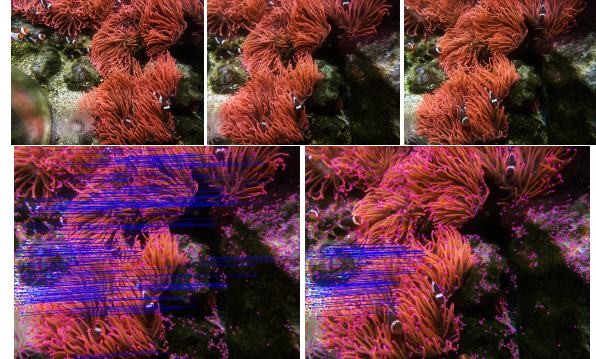
Figure 9. Example of matching result on a synchronised pair (left) and desynchronised pair (right) of anemones: we get more than three times more inliers for the synchronized pair than for the desynchronised pair. Again, most of the inliers of the desynchronised pair are on statics parts (ground).